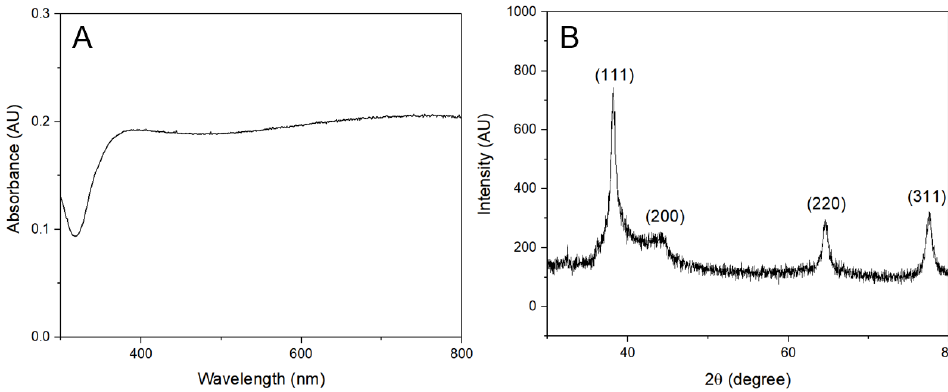
Figure 4. Characterization of the AgNPs synthesized with grapefruit peel extract. ( A ) UV-vis ab- sorbance spectrum of the AgNPs. ( B ) XRD pattern of the AgNPs with labeled diffraction peaks.